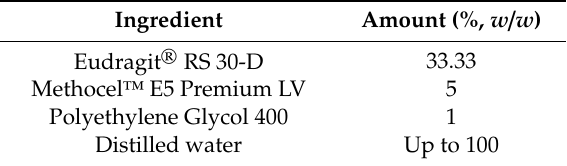
Table 7. The composition of the Eudragit ® and Methocel ™